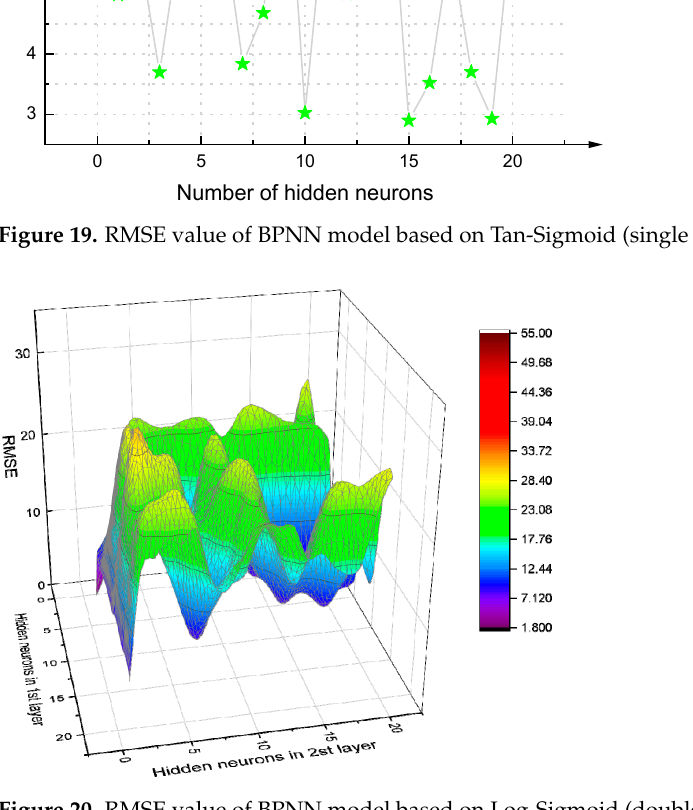
Figure 21. RMSE value of BPNN model based on Tan-Sigmoid (double hidden layers). Figure 22 shows the error reduction process during the BPNN training, which pro- vides an optimal representation of the model training process. The blue line in the figure represents the network training error, the green line represents the network verification error, and the red line represents the test error. The training stops when the verification error reaches the set target or the verification error is no longer decreasing. Figure 23 shows the training status of BPNN.